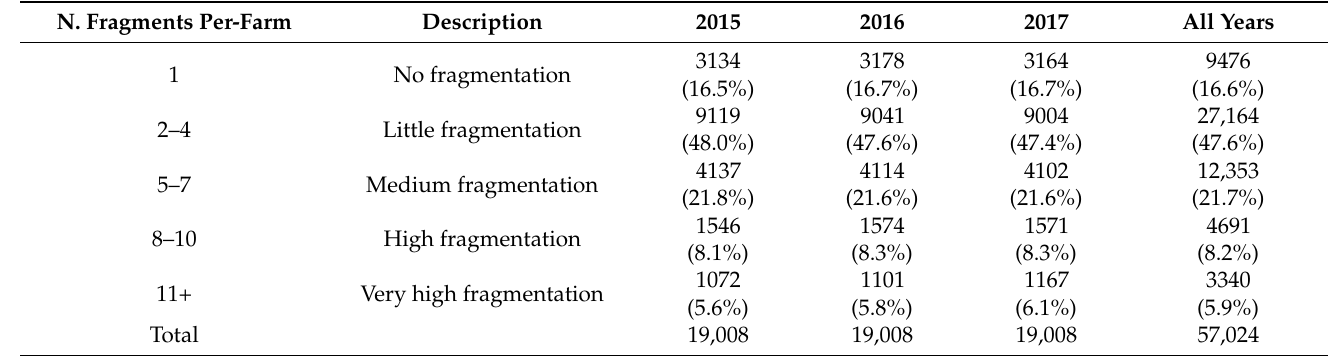
Table 1. The degree of farmland fragmentation in Northern Ireland for 19,008 farms throughout the three study years